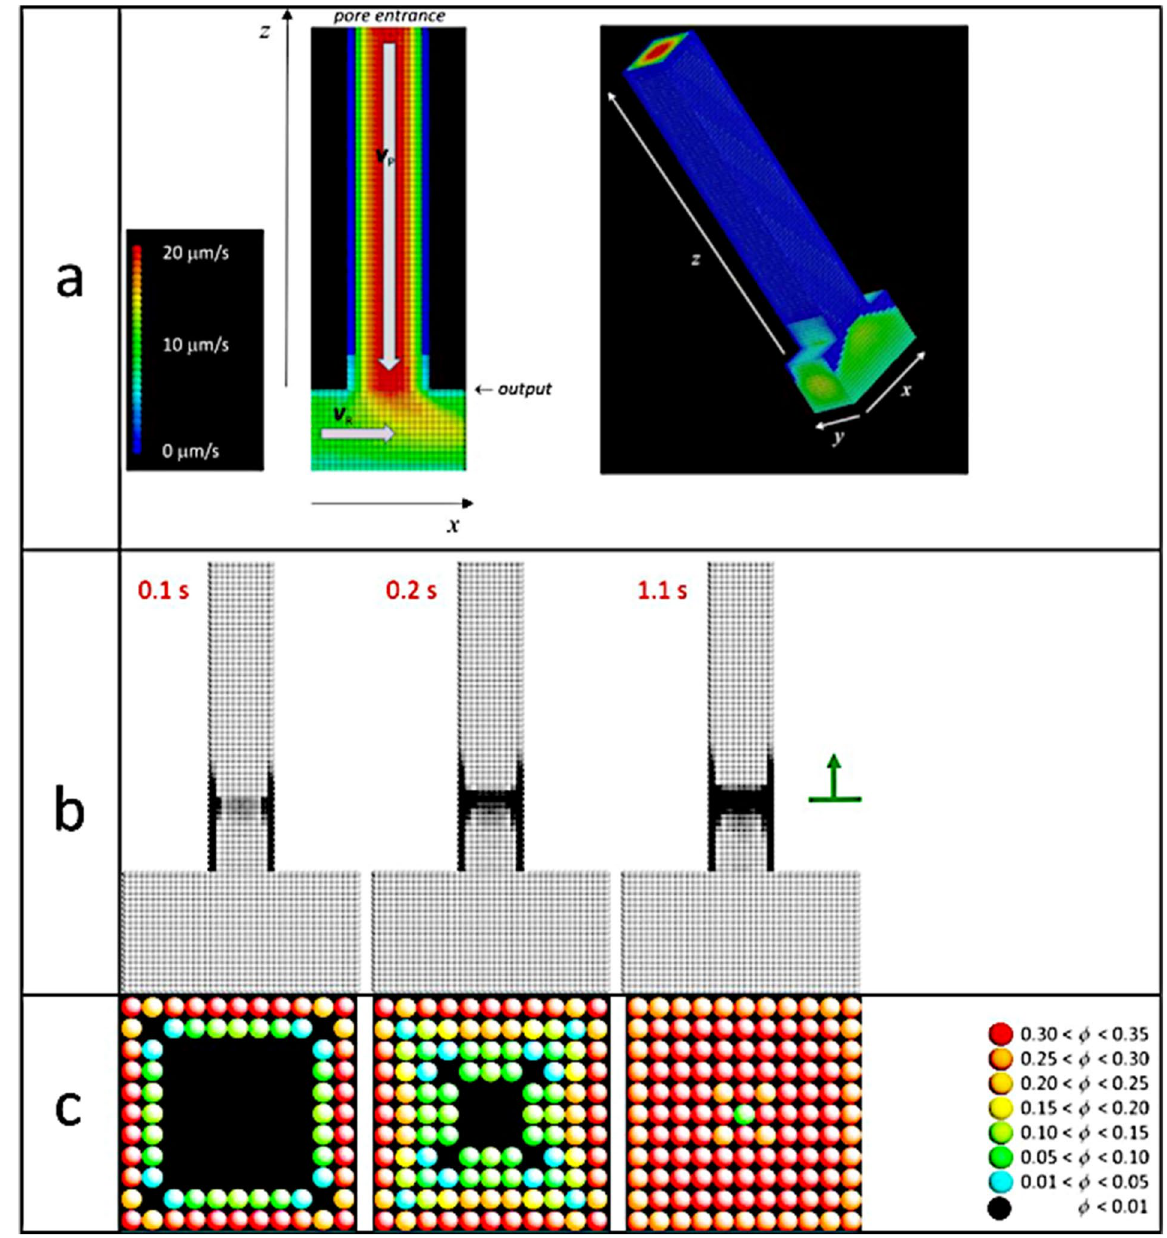
Figure 6. ( a ) Left: longitudinal section plane y = 0 of a pore of square section with the perpendicular ACH channel, used in the ATSIM3D numerical model. Pore outlet is marked with an arrow. A source of sweat proteins is placed at the pore entrance (top). Space is discretized in small elementary cubes of edge length 24 nm. In this example, the fluid velocity is v P = −20 μm s −1 along the z -axis in the pore, and v R = ±10 μm s −1 along the x -axis in the ACH channel. Colours correspond to the magnitudes of the velocity field (the colour map used for the velocities is on the left-hand side of the figure). Poiseuille flow is assumed in both channels. Right) Twisted view of the 3D simulated pore with flow inside. ( b ) Pictures of optical opacity during plug formation within the sweat channel at three different times in a 3D numerical simulation. Numerical parameters: space discretization = 24 nm; time discretization = 270 ns. System parameters: pore dimensions = 0.26 × 0.26 × 2.6 μm; ACH channel dimensions: 0.5 × 0.26 × 0.5 μm; pore flow velocity = 40 μm s −1 (top to bottom); ACH channel flow velocity = 10 μm s −1 (left to right). Chemical species: sweat protein concentration (source at the entrance of the pore) = 1 mM; sweat protein hydrodynamic radius = 3 nm and coordination number = 4 ; ACH molecule concentration (source upstream the ACH channel) = 1 mM; ACH hydrodynamic radius = 1 nm and coordination number = 4. Shades of grey follow: 1− e − a m , with m is the total gel mass along the line of sight and a is a positive numerical coefficient (white = low density; black = high density). The green arrow on the right-hand side is a mark to point the cut plane. ( c ) Pictures of transverse sections in the middle of the plug (green arrow) inside the sweat channel, for the three times of the simulated system. The elementary cells are cubes in the simulations but they are represented here as spheres for better visual separation. False colours correspond to values of the local plug density, . The colour map is shown on the right-hand side of the ϕ